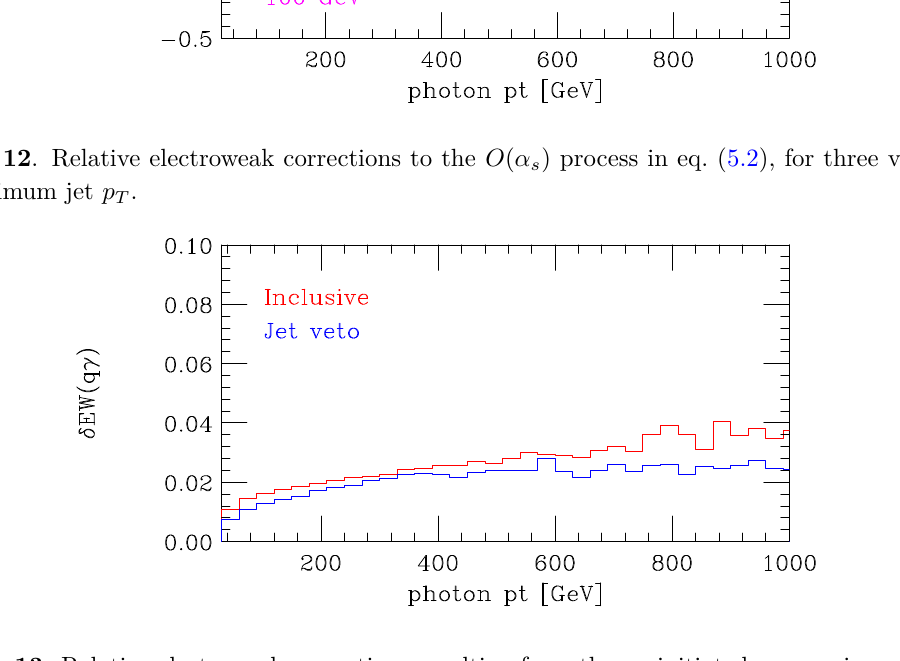
Figure 13 . Relative electroweak corrections resulting from the qγ -initiated process in eq.